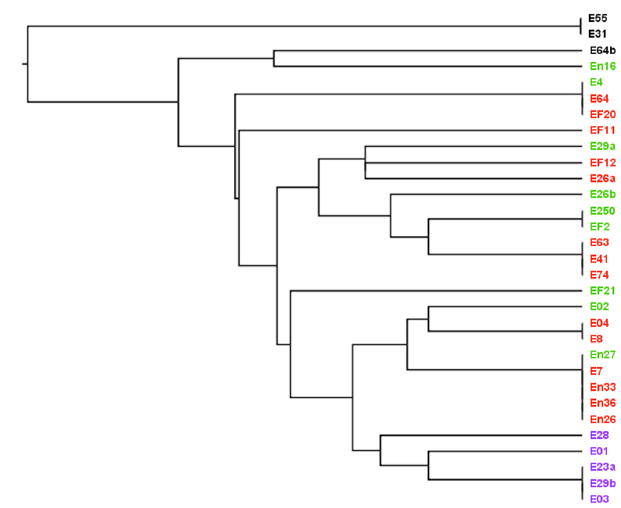
Chi-square = 11.92 P = 0.0026 Significant at P < 0.01 Table 5. Genotype–phenotype associations of gelA, fsrAB , and fsrB with gelatinase activity with biofilm formation strength + , positive; − , negative; A: positive for fsrA only; A&B: positive for both fsrA and fsrB . * Fisher Exact Test applies only to 2 × 2 tables.